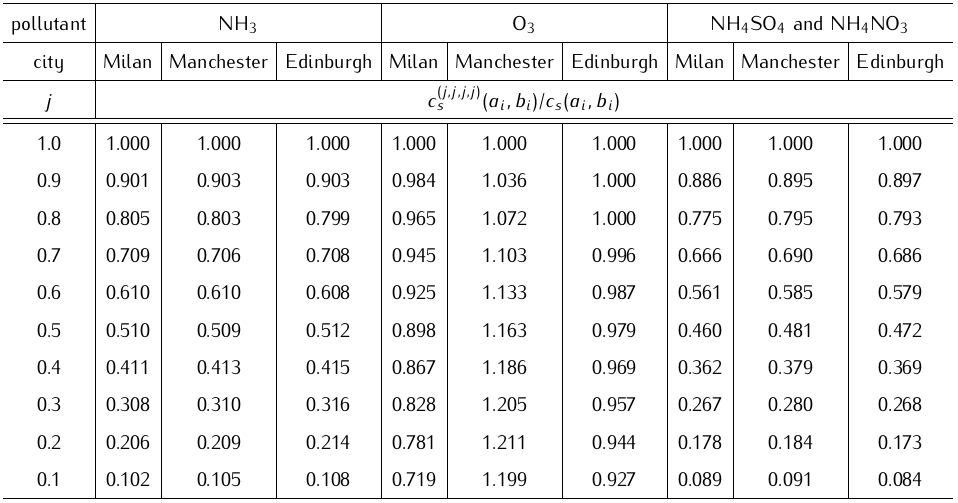
Table 1. The ratios c ( α 1 ,α 2 ,α 3 ,α 4)